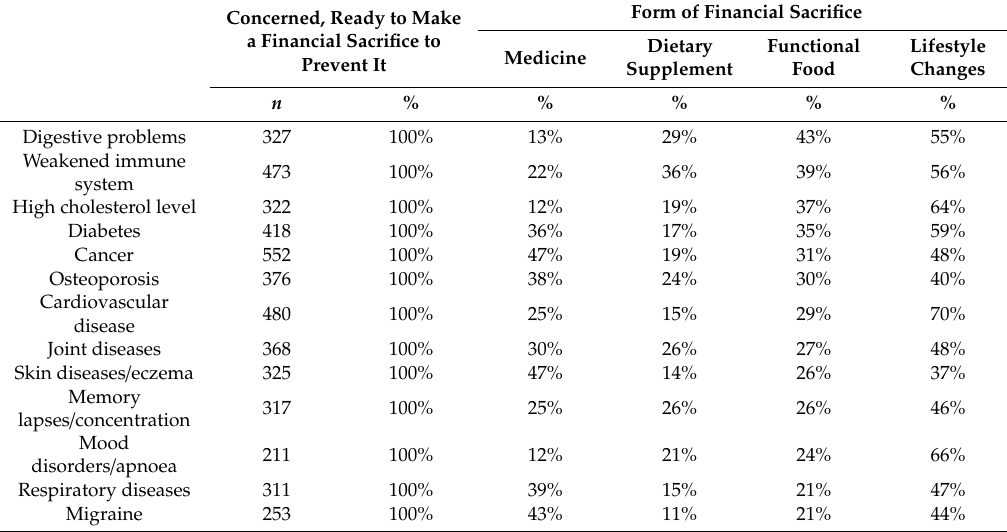
Table 3. The form of financial sacrifice worried respondents are willing to